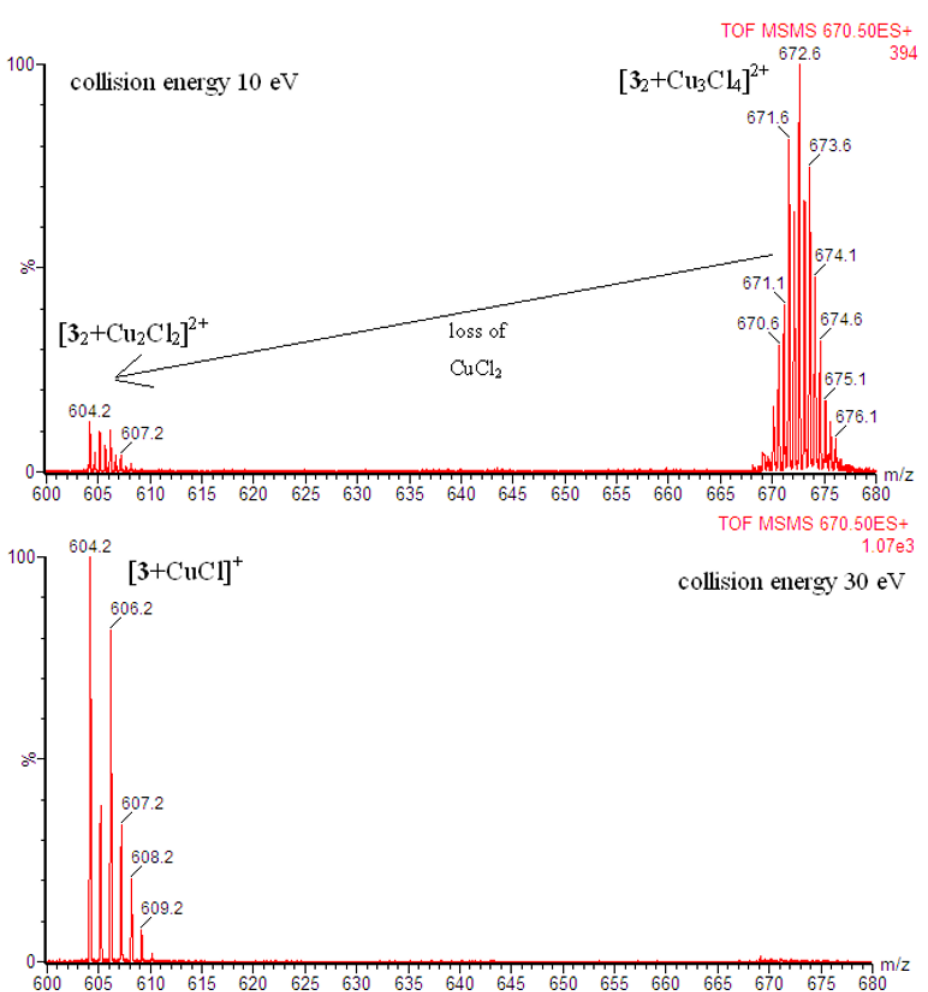
Figure 7. CID MS/MS spectra of ion [3